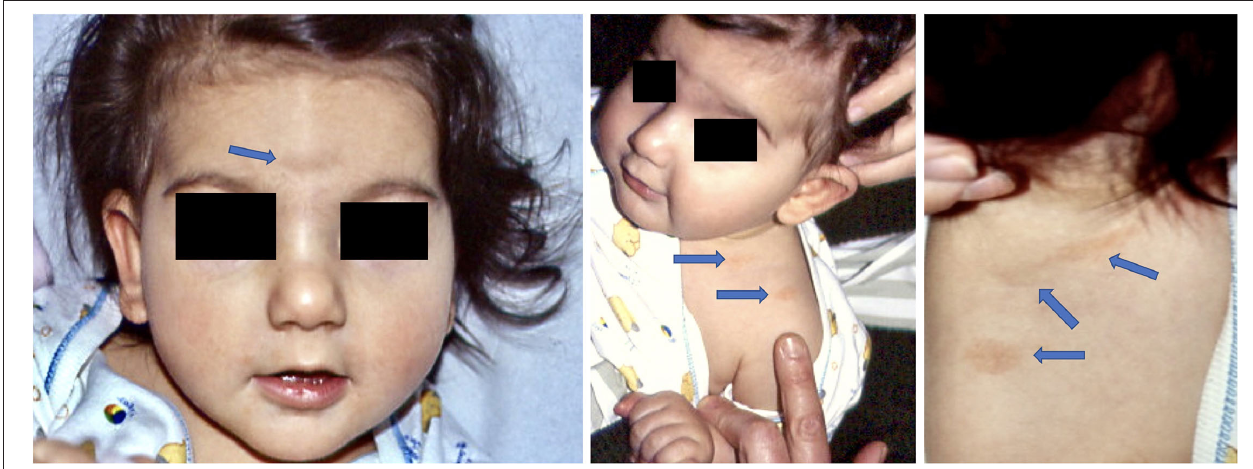
FIGURE 2 | Child born with angiomatous patches at 7 months (Case 9). At 1 year examination angiomatous lesions were still visible, but not at 2 years